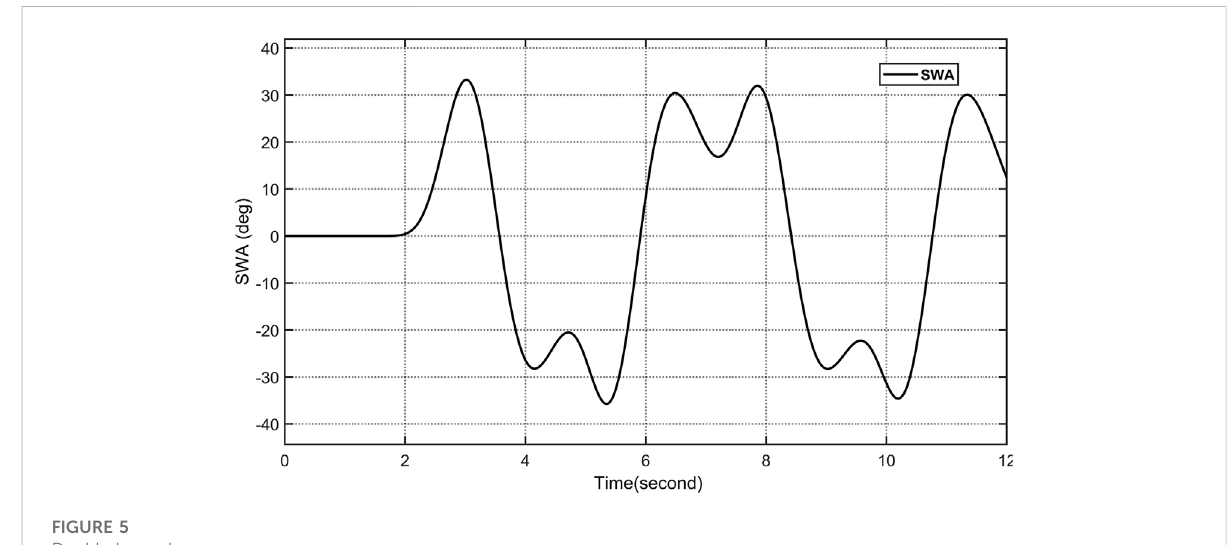
FIGURE 5 Double Lane change